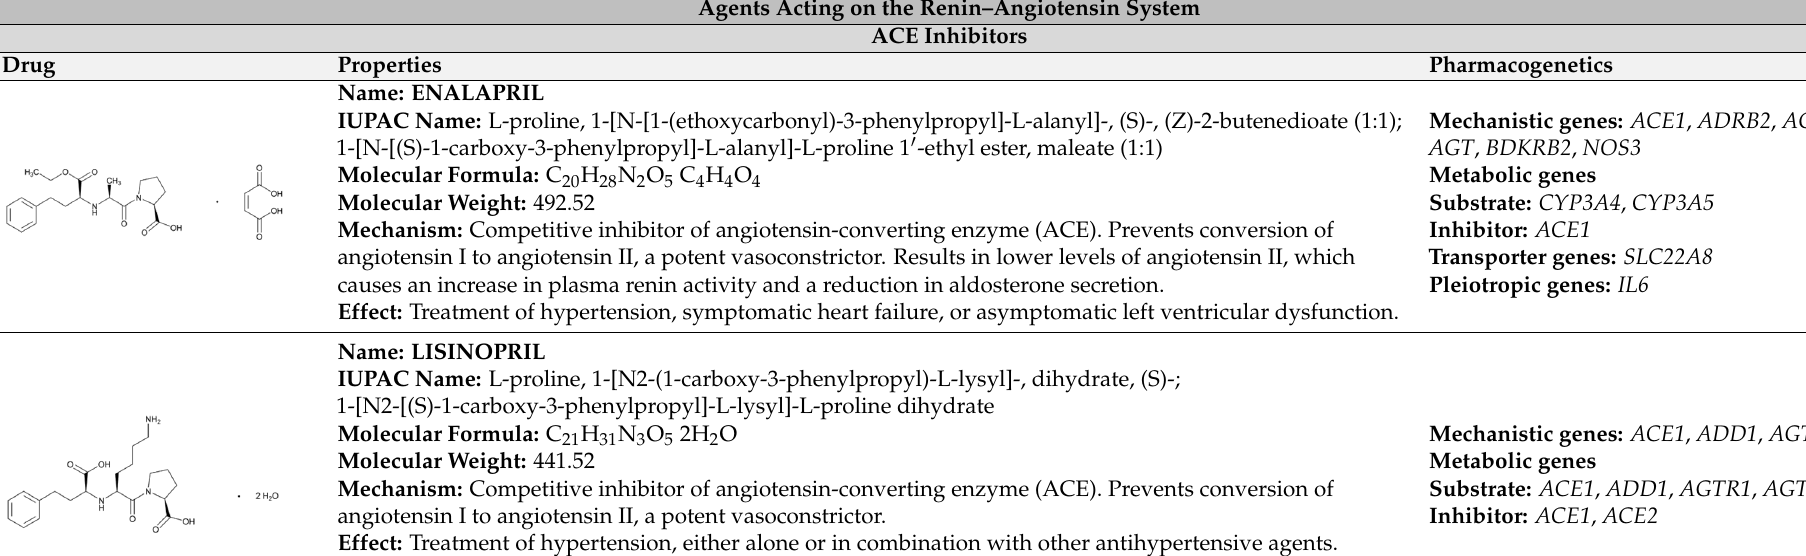
Table 1. Pharmacogenetics of selected drug categories with effects on the cardiovascular system.